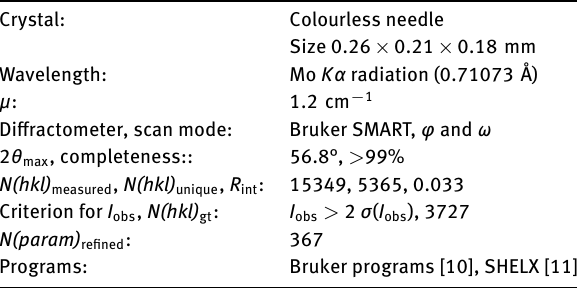
Table 2: Fractional atomic coordinates and isotropic or equivalent isotropic displacement parameters (Å 2